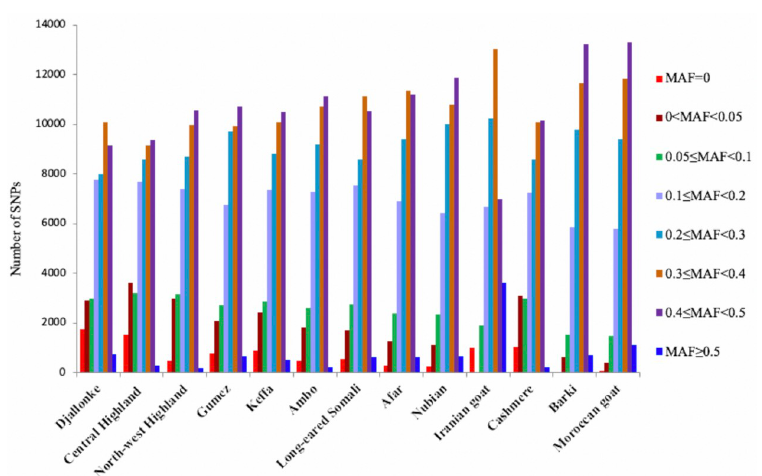
The results of the STRUCTURE analysis (2 � K � 15) are present in Fig 9. In the dataset used, K = 6 was the optimal K value (S1 Fig) and Cameroon goats demonstrated two major genetic backgrounds. In the first genetic background (at cluster2), Central Highland, North- west Highland, and Djallonke goats had 53.66%, 91.60%, and 63.72% similar genetic back- ground, respectively, in which Moroccan goat shared 16.31% (S7 Table). North-west Highland (43.06%) and Djallonke (34.26%) goats shared the next highest proportion of common genetic background at cluster4, in which Moroccan goat shared 26.26% similar genetic background. Similarly, the goat populations found in hot and arid areas of Ethiopia (Afar, Long-eared Somali, and Nubian) separated from the cohorts found in highland and humid environments